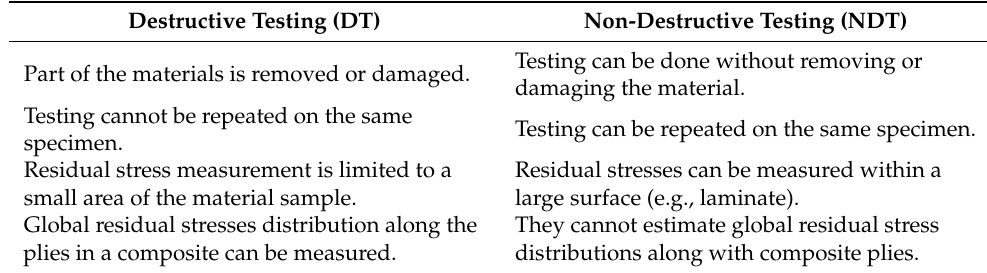
Table 3. Difference between destructive and non-destructive testing. Destructive Testing (DT) Non-Destructive Testing (NDT) Testing can be done without removing Part of the materials is removed or damaged.